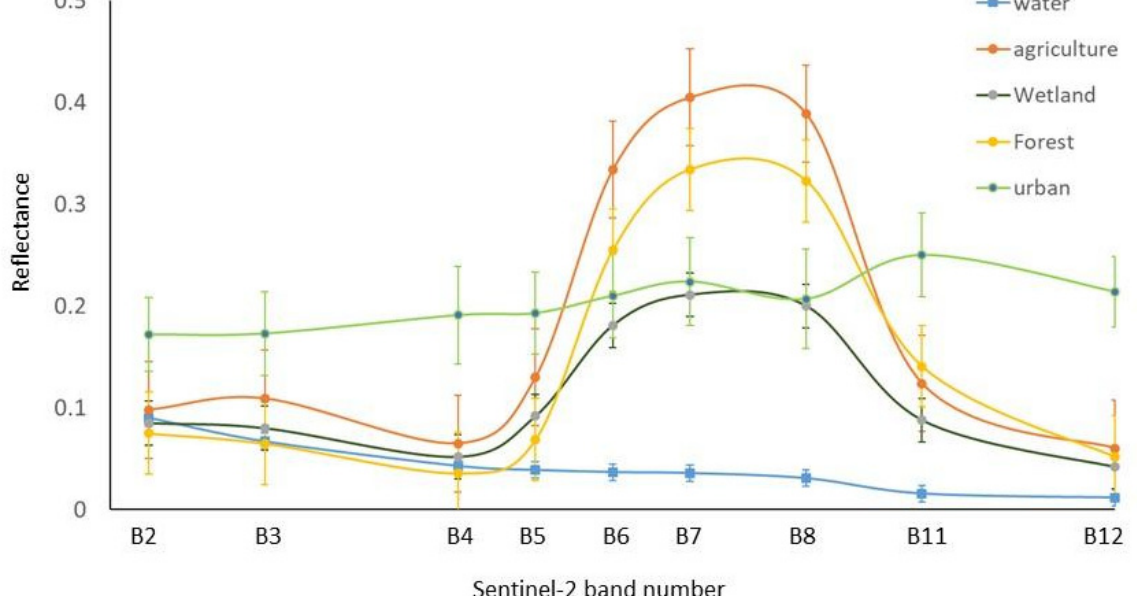
Figure 2. Spectral reflectance during summer months from Sentinel-2 optical bands of large bodies of deep open water compared to inundated wetlands and other land cover types in a portion of the study area. Wetland water shows different spectral characteristics compared to deep open water, likely due to the presence of submerged and emergent vegetation. The error bar shows the standard deviation of spectral reflectance of pixels for each land cover type.